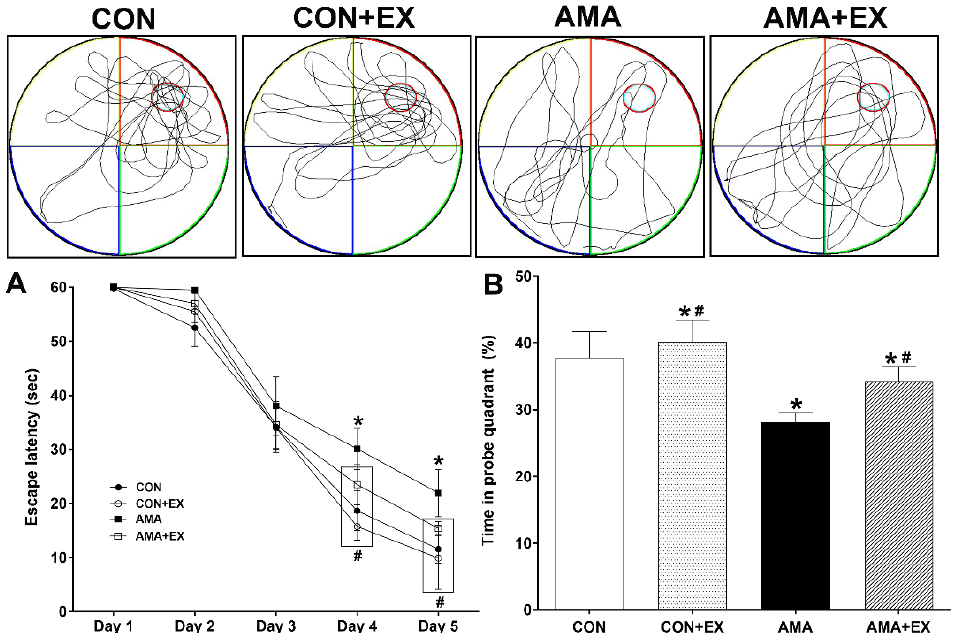
Figure 1. Effects of maternal exercise on spatial learning ( A ) and memory ( B ) in the offspring from mothers with advanced maternal age (AMA). The Morris water maze task was used to evaluate spatial learning and memory. CON: offspring from the control group; CON + EX: offspring from the control and exercised group; AMA: offspring from the advanced maternal age group; AMA + EX: offspring from the advanced maternal age and exercised group. Data are expressed as means ± standard error of the mean (SEM). * p < 0.05 compared to the CON group. # p < 0.05 compared to the AMA group.